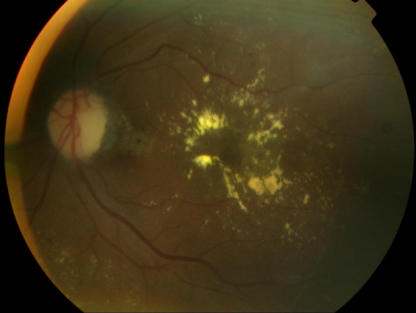
Non-Proliferative Diabetic Retinopathy Showing Several Exudates around the Macula